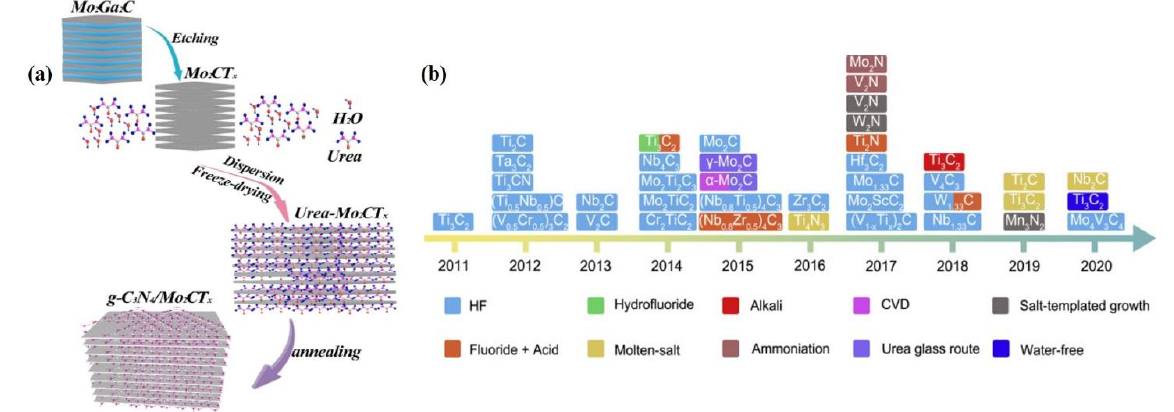
Figure 2. ( a ) Illustration for the preparation of the Mo 2 CT x /g-C 3 N 4 hybrid by mechanical exfoliation using HF as etchant, ( b ) schematic of the synthetic exfoliation protocols of molybdenum and other MXenes reported over the last two decades [14,15] . Copyright 2021 Elsevier.